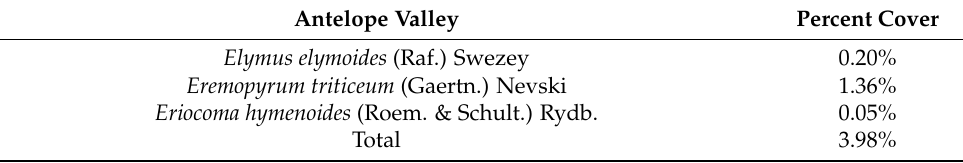
Table 2. Cont. Antelope Valley Percent Cover Elymus elymoides (Raf.) Swezey 0.20% Eremopyrum triticeum (Gaertn.) Nevski 1.36% Eriocoma hymenoides (Roem. & Schult.) Rydb. 0.05% Total